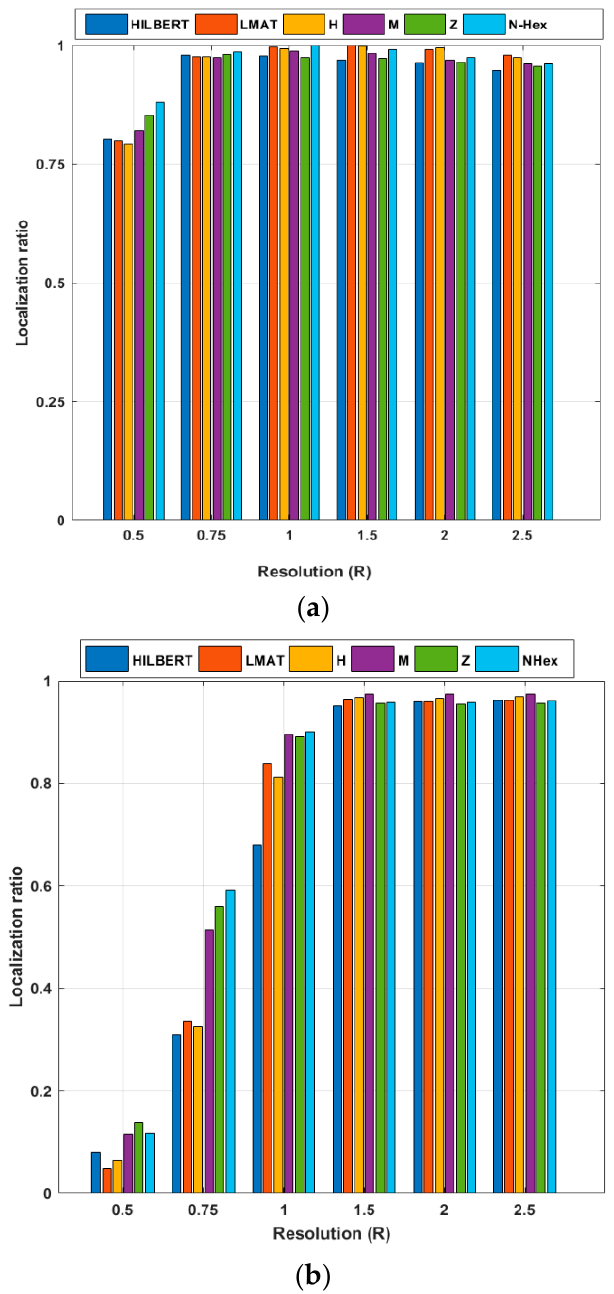
Figure 16. Localization ratio of the path planning models by resolution ( σ = 7) ( a ) WCL, and ( b ) APT